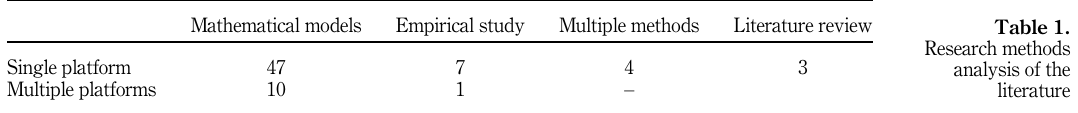
Table 1. Research